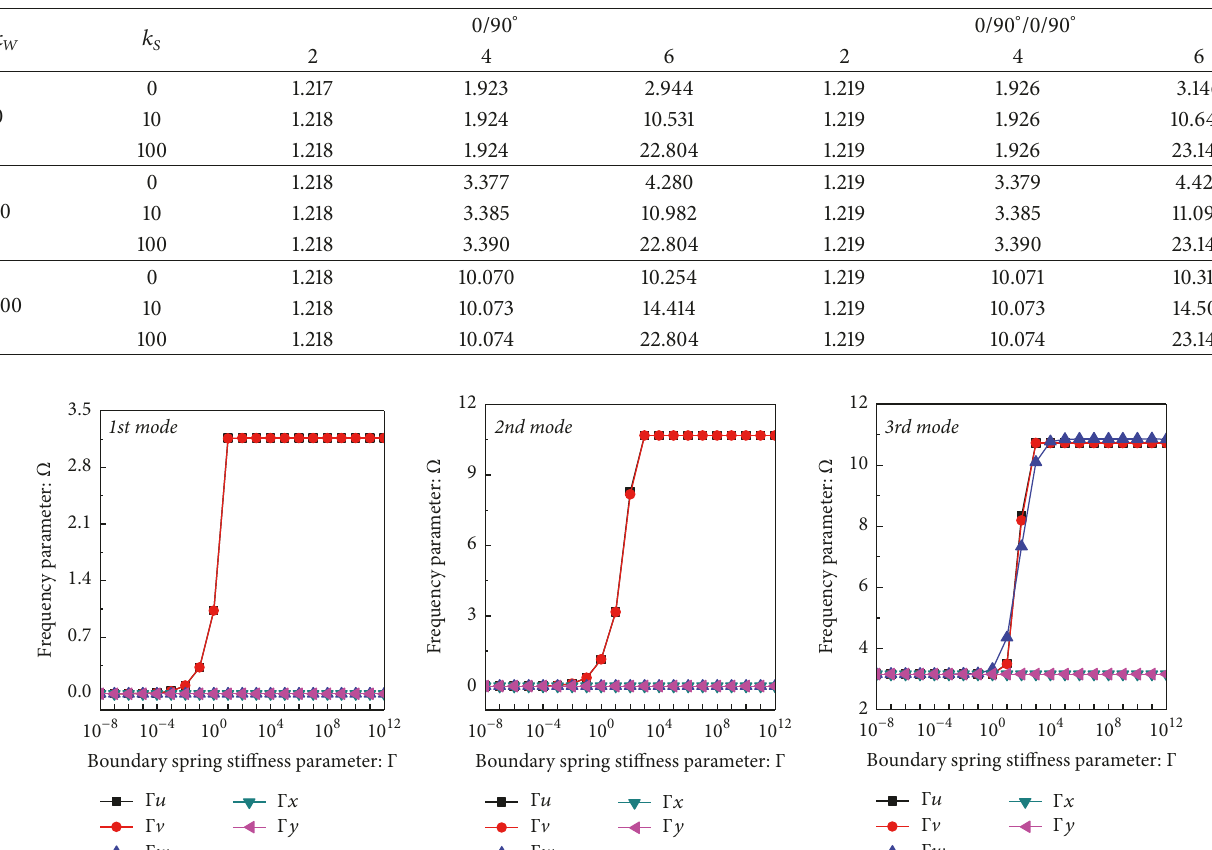
Table6:Frequencyparameter Ω fortwocross-plysquareplateswith8-pointelasticsupportedboundaryconstraintsanddifferentfoundation parameters (Material II) .